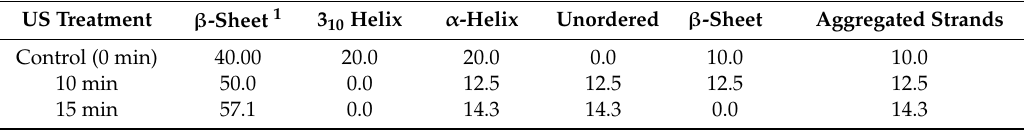
Table 6. Protein secondary structures of L. mutabilis protein isolates obtained during ultrasound-assisted alkaline extraction and isoelectric precipitation